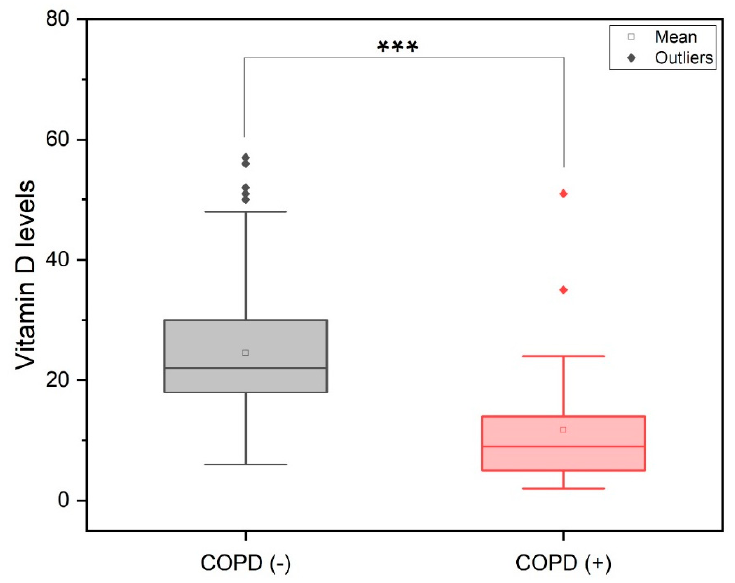
Figure 1. Vitamin D levels according to the status of chronic obstructive pulmonary disease. *** Mann-Whitney test ( p < 0.001).